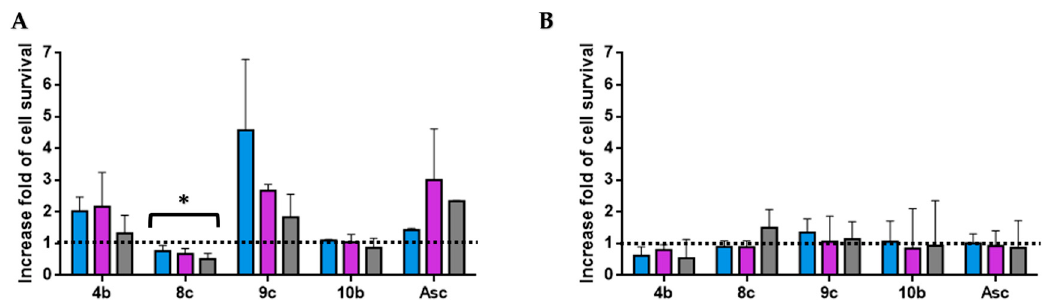
Figure 5. Antioxidant activity of hit compounds at 0.03 mg / mL ( A ) and 0.003 mg / mL ( B ) was evaluated using the H 2 O 2 -induced HT-29 cells oxidative damage model at 300 (blue), 250 (violet), and 200 µ M (grey). The results are expressed as an increase fold of cell survival. Significance: * p < 0.05 compared with Asc.